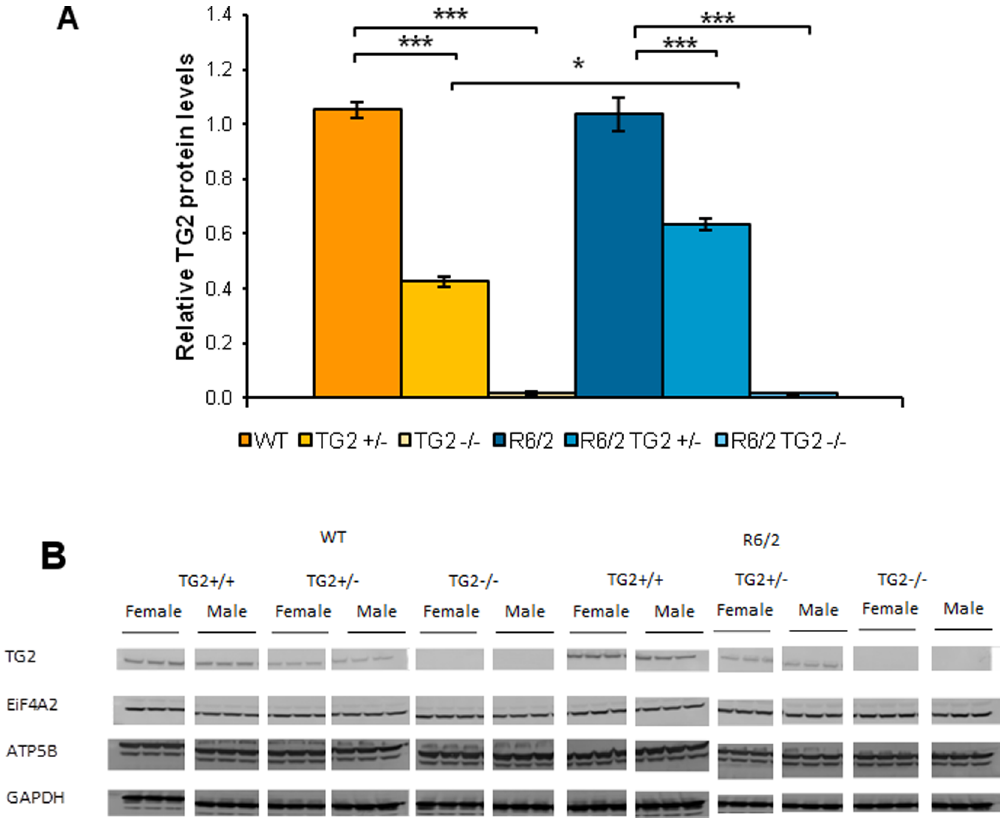
Figure 1. Transglutaminase 2 protein levels in R6/2 6 TG2 KO line. A. TG2 expression levels in the striatum of 12 week old animals from the R6/2 6 TG2 KO line (n=11–12 per genotype). * p , 0.05,*** p , 0.0001. See materials and methods’ section for details regarding the calculation of TG2 protein expression levels. B. Westen blotting examples of striatal lysates of animals from the R6/2 6 TG2 KO line probed with antibodies that recognize TG2 and the housekeeping